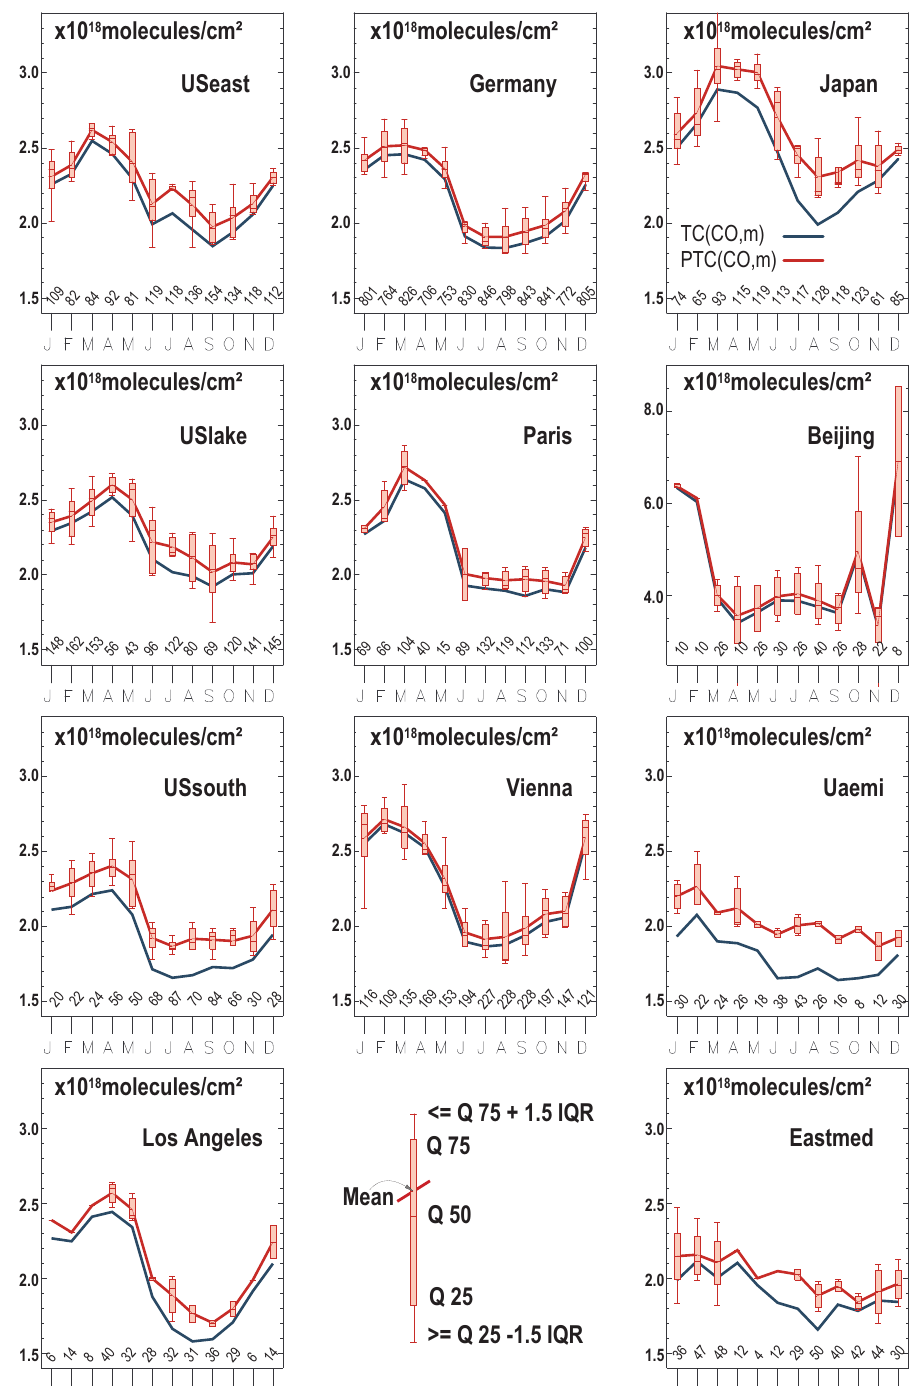
Fig. 6. Same as Fig. 5 but for CO, expressed in × 10 18 moleculescm − 2 . Note that only Beijing is plotted with a different scale.